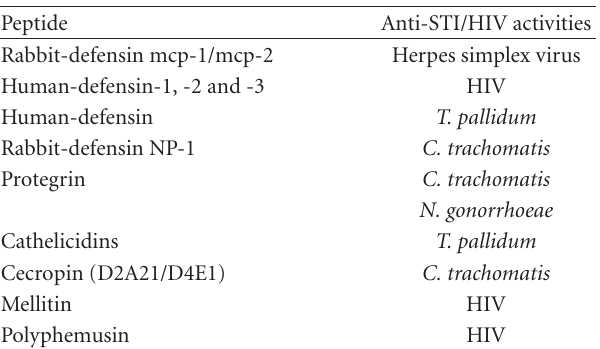
Table 2: Activity of antimicrobial peptides against sexually trans- mitted infection causing pathogens